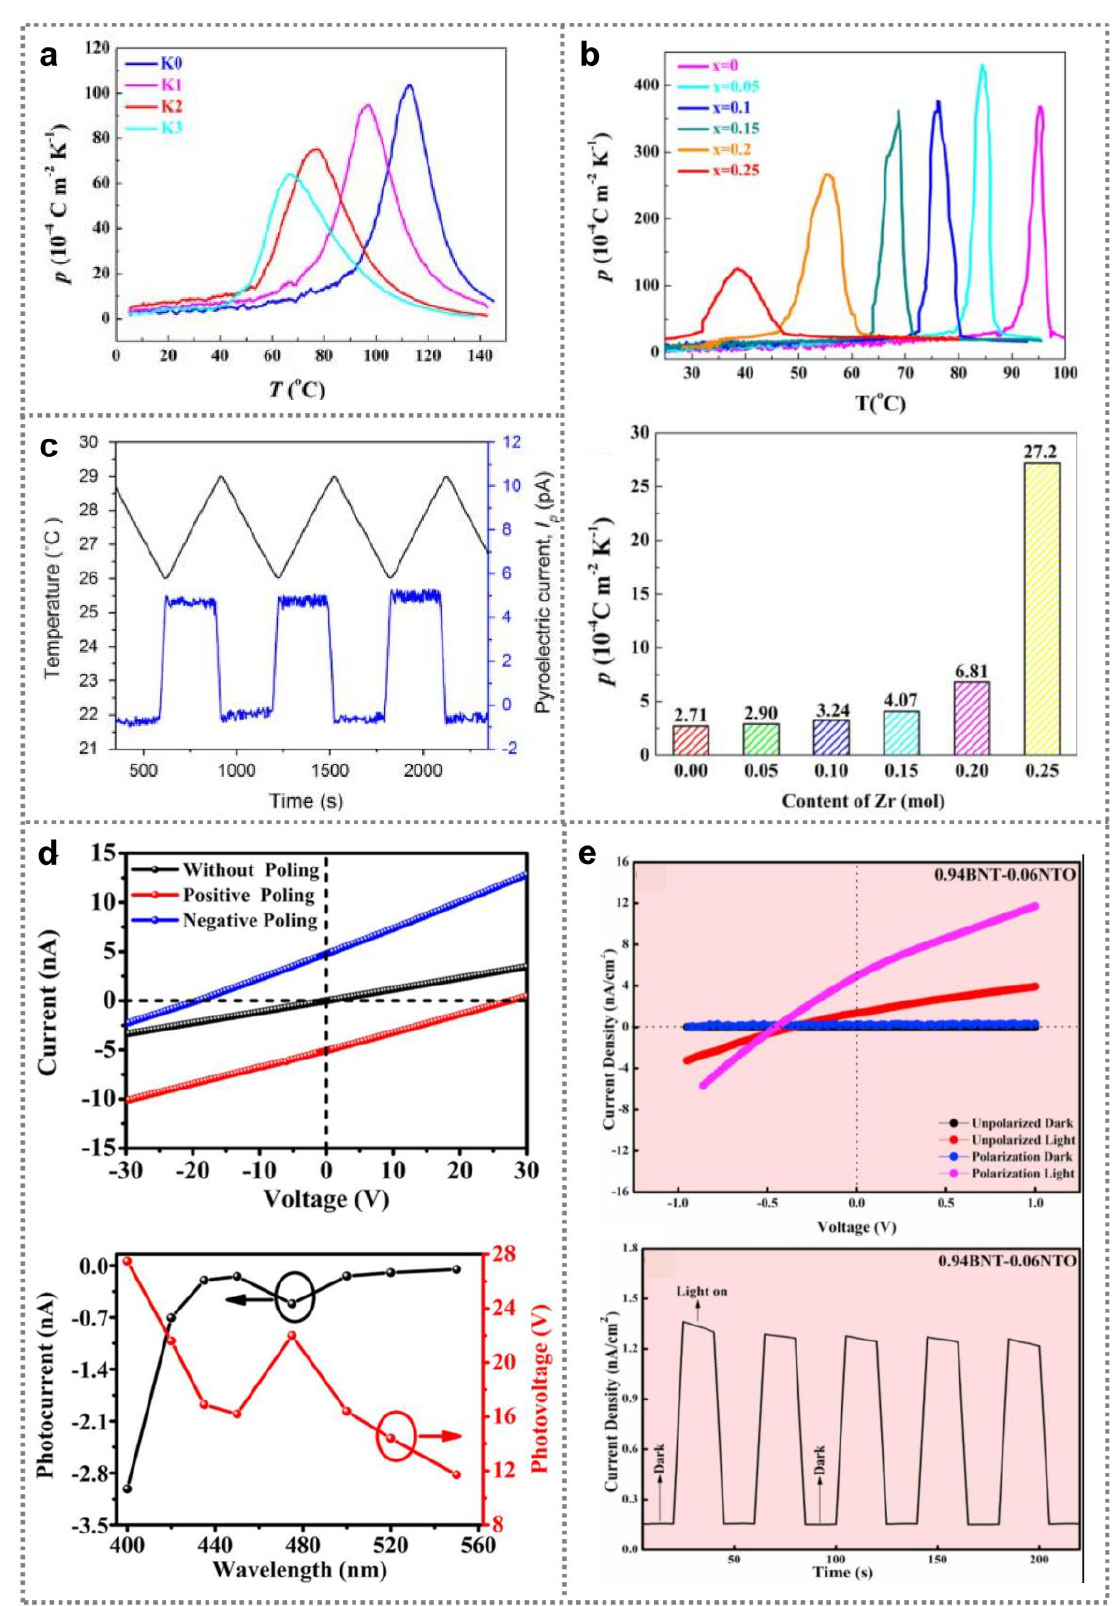
Figure 5. Pyroelectric and photovoltaic properties of BNT ferroelectric nanomaterials. ( a ) Temperature-dependent pyroelectric coefficients of BNT-BA-xKNN ceramic sample containing various amount of KNN (Reproduced with permission from [83], Wiley, 2019). ( b ) Pyroelectric coefficients of 0.94Bi 0.5 Na 0.5 TiO 3 -0.06BaTi 1-x Zr x O 3 ceramics with different Zr content (Reproduced with permission from [84], Elsevier, 2019). ( c ) Time-dependent temperature variation and pyroelectric